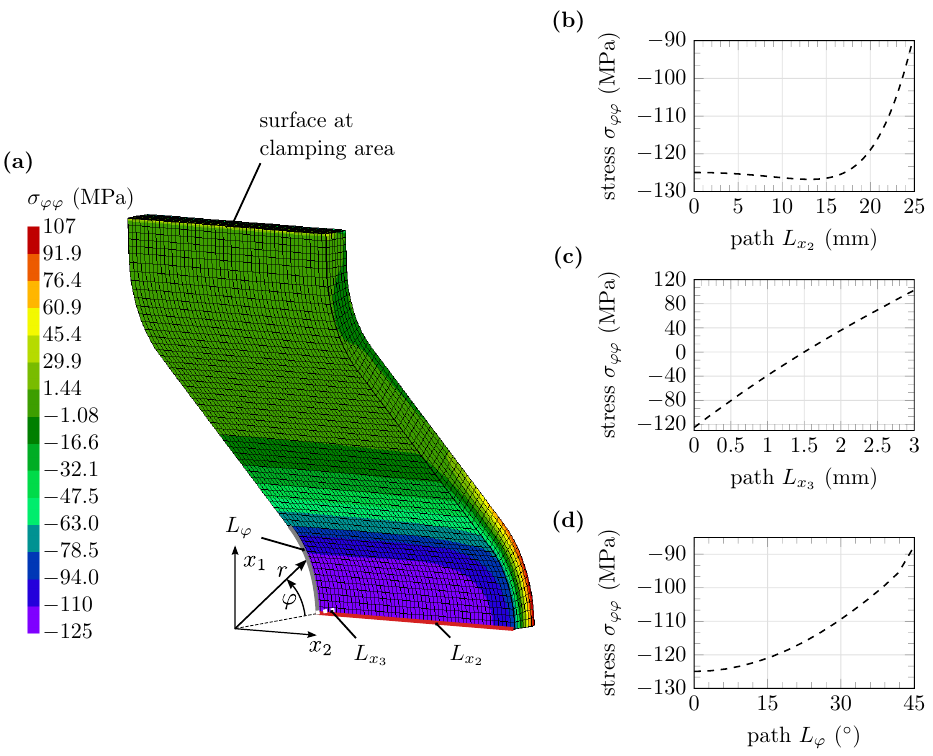
Figure 4. Numerical simulation of the structural component made of AZ31B with bending radius R BS12 = 12mm: ( a ) stress field σ ϕϕ ( r , ϕ , x 2 ) of a FEM quarter model at a given load of F = x 1 -direction; ( b ) stress σ ϕϕ along the path L x the path L ϕ